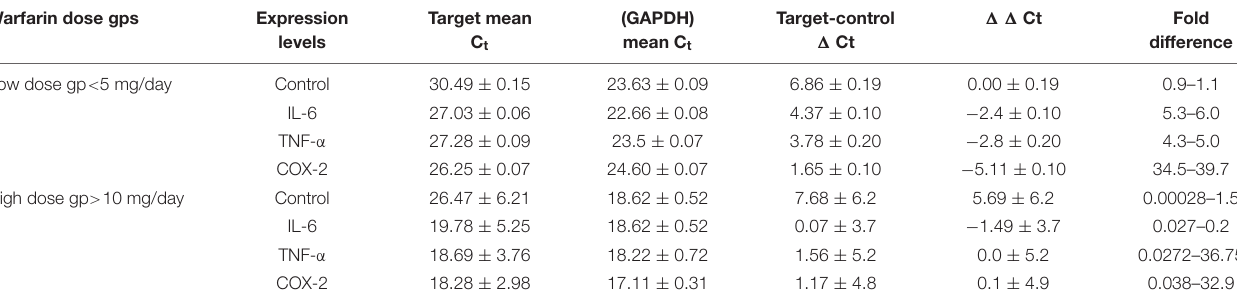
(cid:49) (cid:49) Ct Fold Target mean (GAPDH) Target-control (cid:49) Ct levels C t mean C t